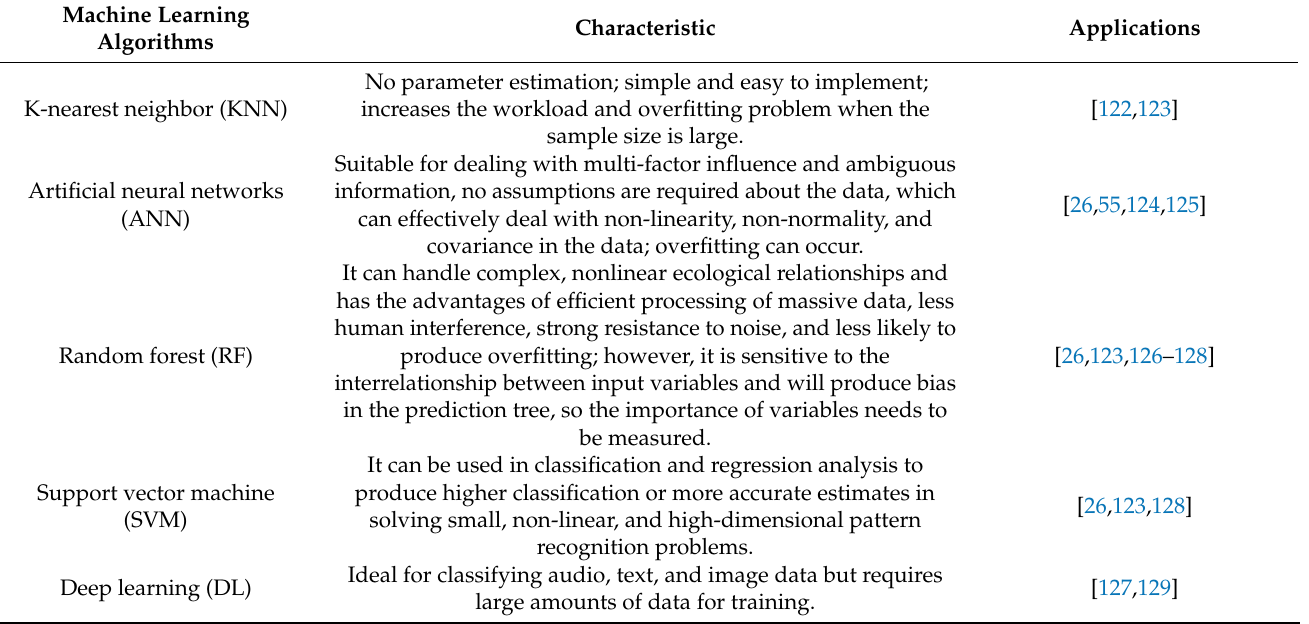
Table 3. Comparison of standard machine learning algorithms for forest ecosystem quality